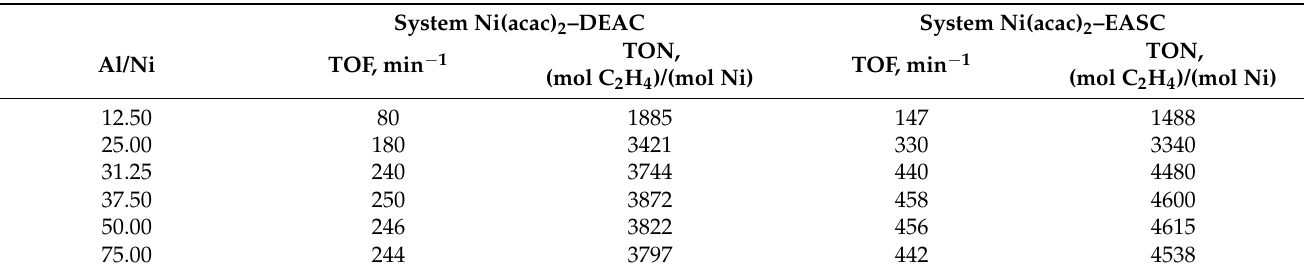
Table 1. Ethylene oligomerization in the presence of Ni(acac) 2 –DEAC and Ni(acac) 2 –EASC catalytic systems at different Al/Ni ratios. Data were taken from ref. [13,16].